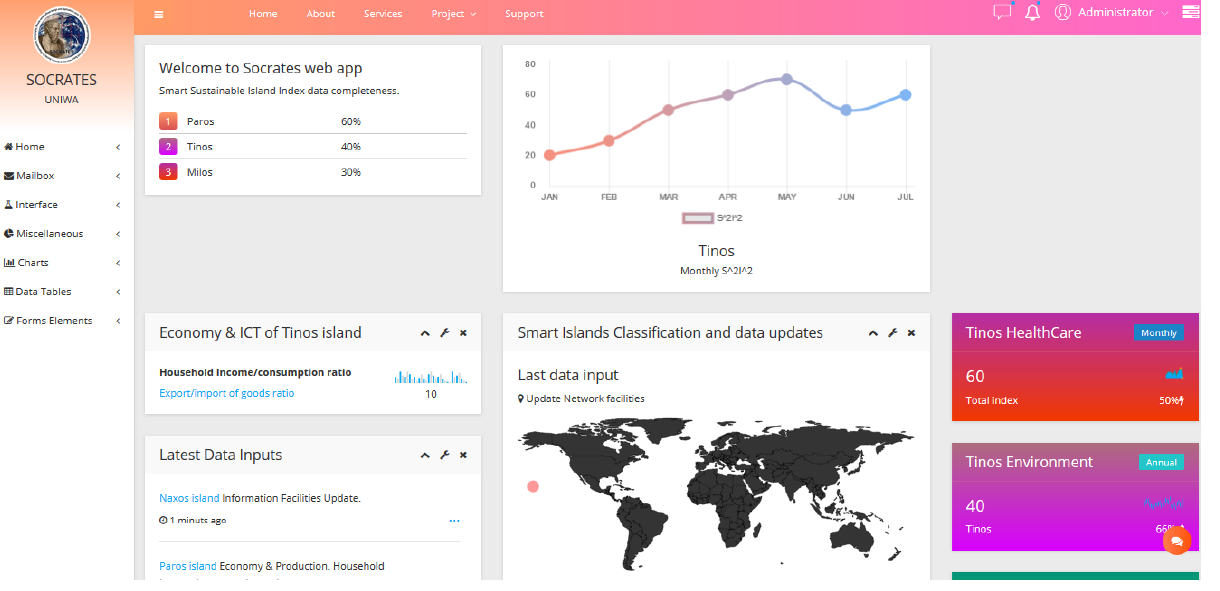
Figure 6. Sample webpage of the island’s information dashboard. From left to right several info windows for e.g., Tinos